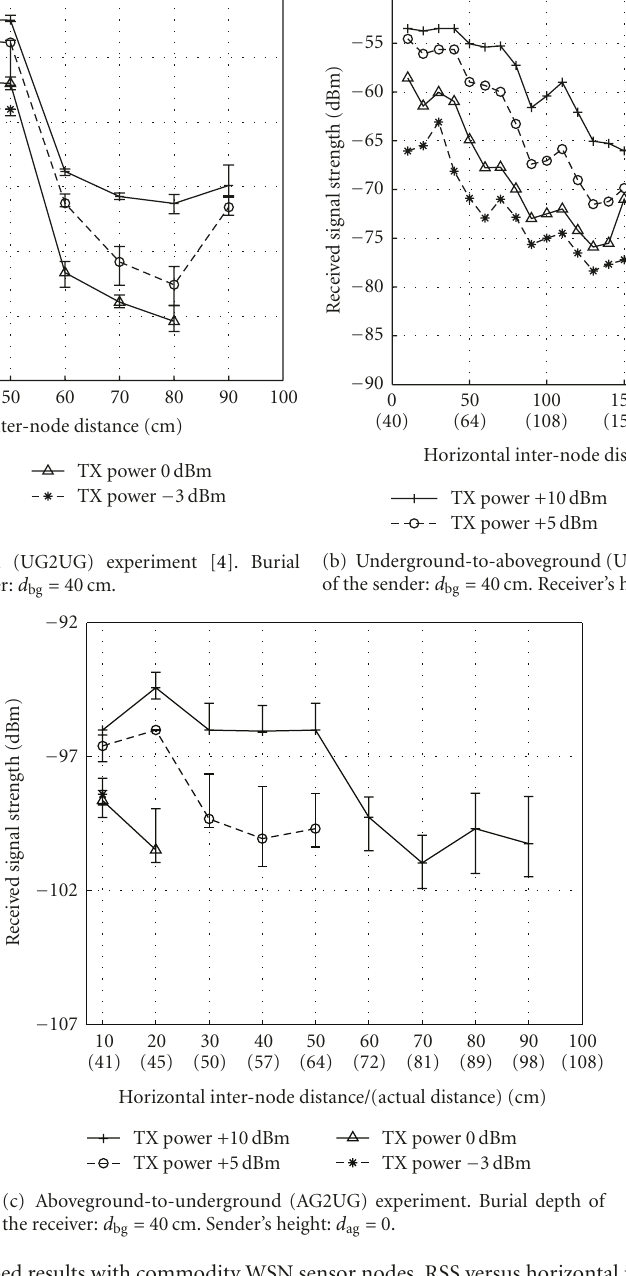
Figure 11: WUSN testbed results with commodity WSN sensor nodes. RSS versus horizontal internode distance d h